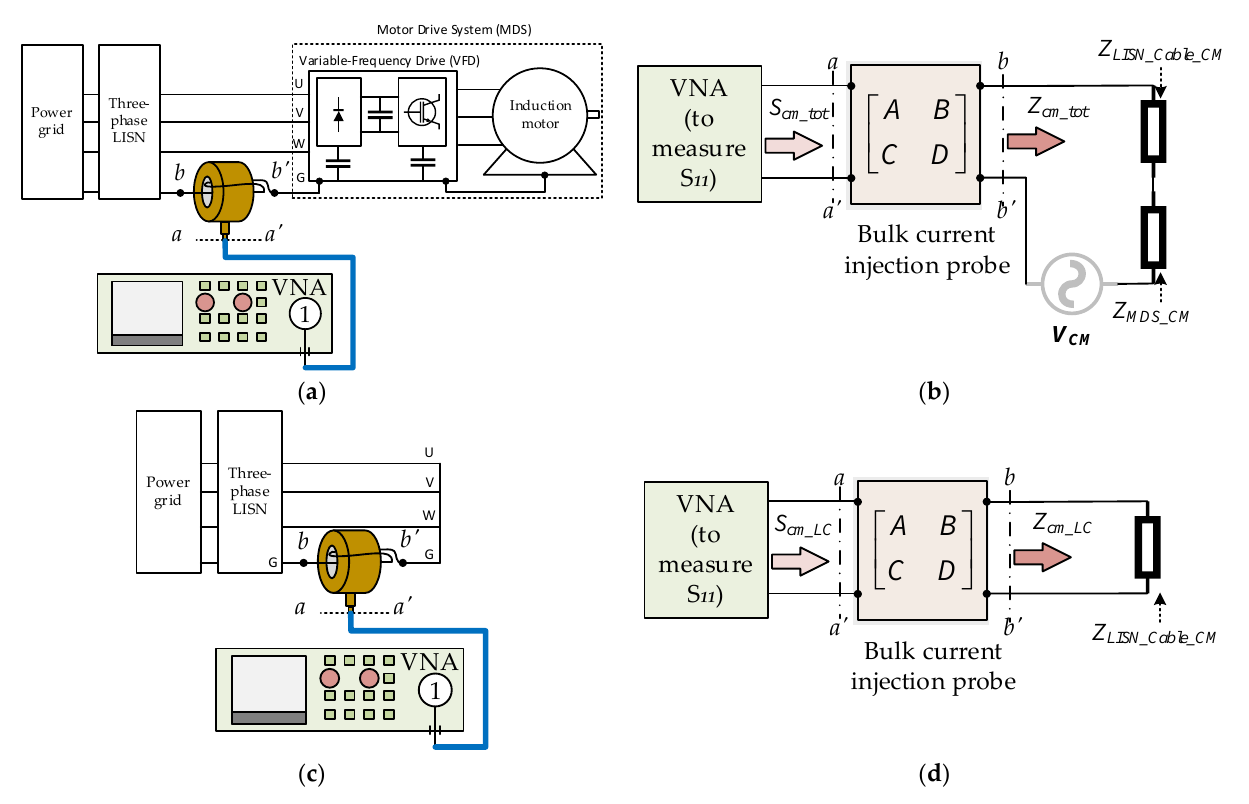
Figure 8. Setups to determine CM equivalent circuit: ( a , b ) in the presence and ( c , d ) in the absence of the motor drive system.